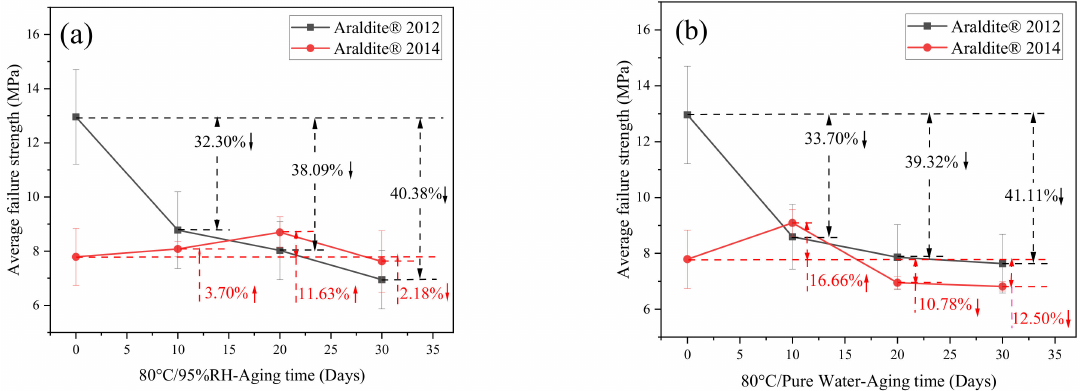
Figure 10. Failure strength of the adhesive joints at different environments: ( a ) Araldite® 2012 and Araldite® 2014 joints in 80 ◦ C/95%RH and ( b ) Araldite® 2012 and Araldite® 2014 joints 80 ◦ C/pure